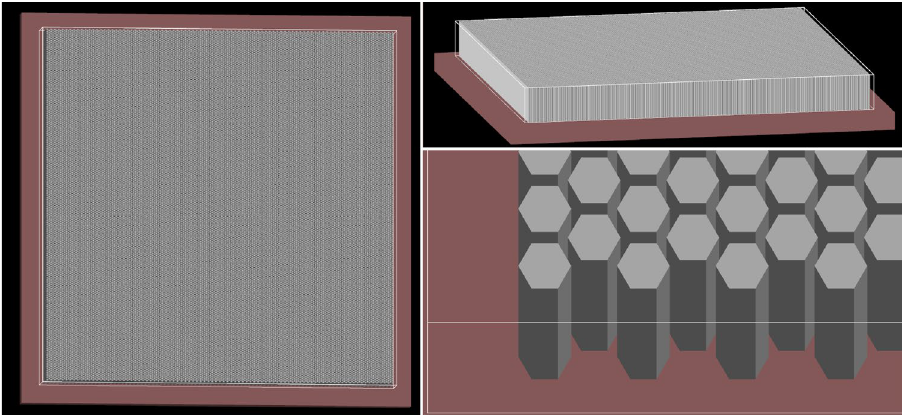
Figure 2. Geant4 model of borosilicate glass faceplate with 100 µm hexagonal capillaries filled with PEALPB similar to the microcapillary plates shown in Fig. 1. Left image: top view of 2 × 2 cm faceplate on top of silicon imager. Upper right: Side view of the model. Lower right: Higher magnification of the 1.2 mm tall PEALPB scintillators in a glass